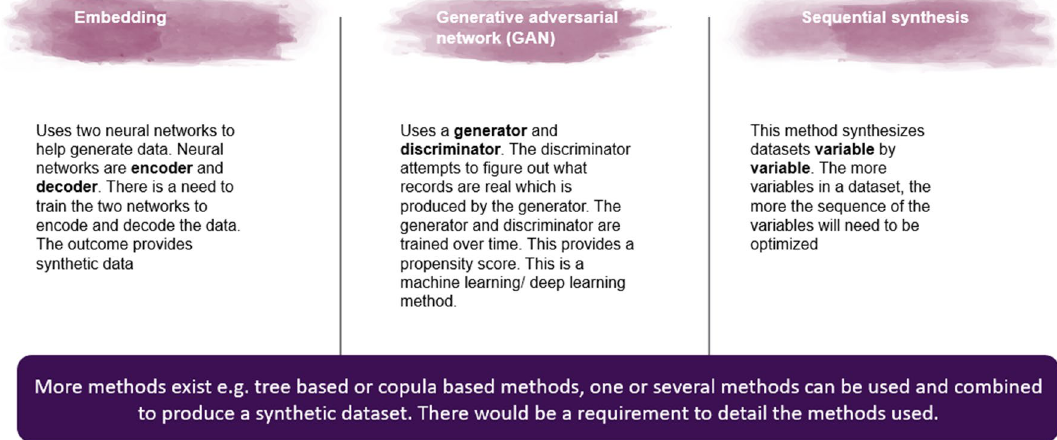
Fig. 2 Example methods that can be used to produce synthetic